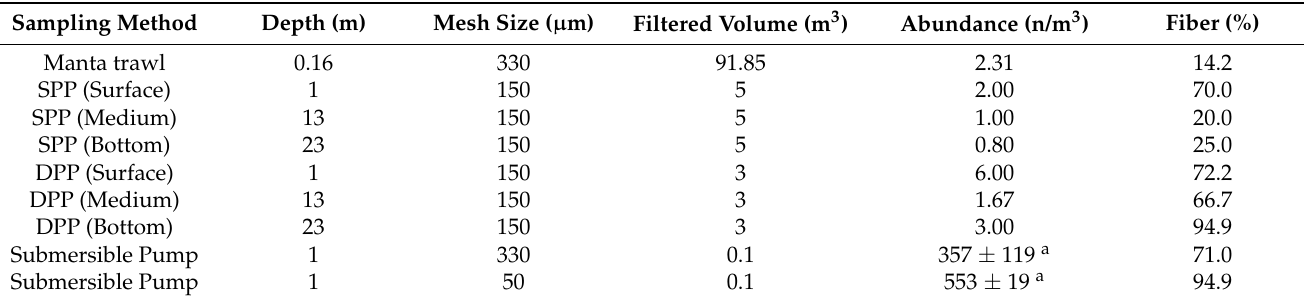
Table 1. Abundance of plastic samples collected by the 4 sampling methods. SPP represented shal- low-water plankton pump; DPP represented deep-water plankton pump (DPP).